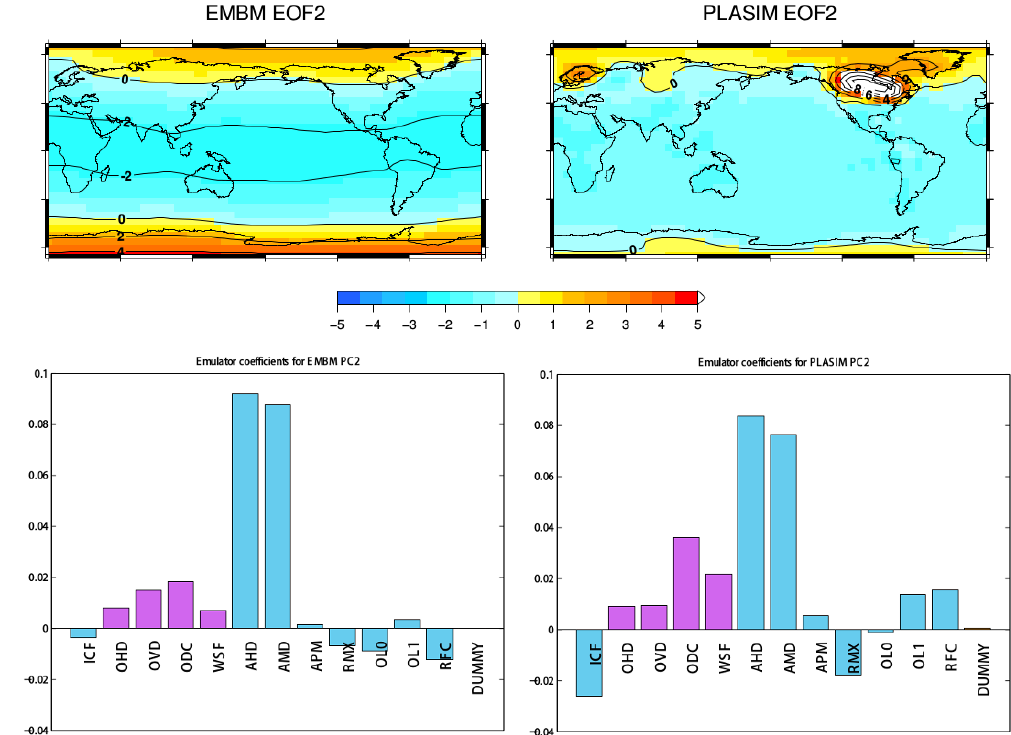
Figure 6. The second EOFs of EMBM and PLASIM SAT (upper) and the universal kriging emulator coefficients of their corresponding PCs (lower). All 600 data points are used to train each of these emulators. The white cells in PLASIM EOF2 indicate values higher than the plotted range. Contours are drawn over both plots at a 2 ◦ C